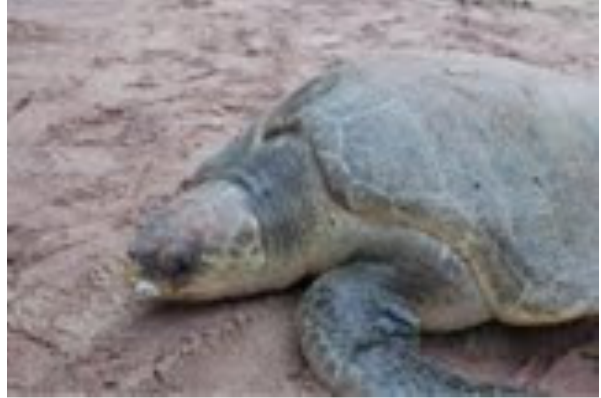
Fig. 1. Closure view of the green turtle at